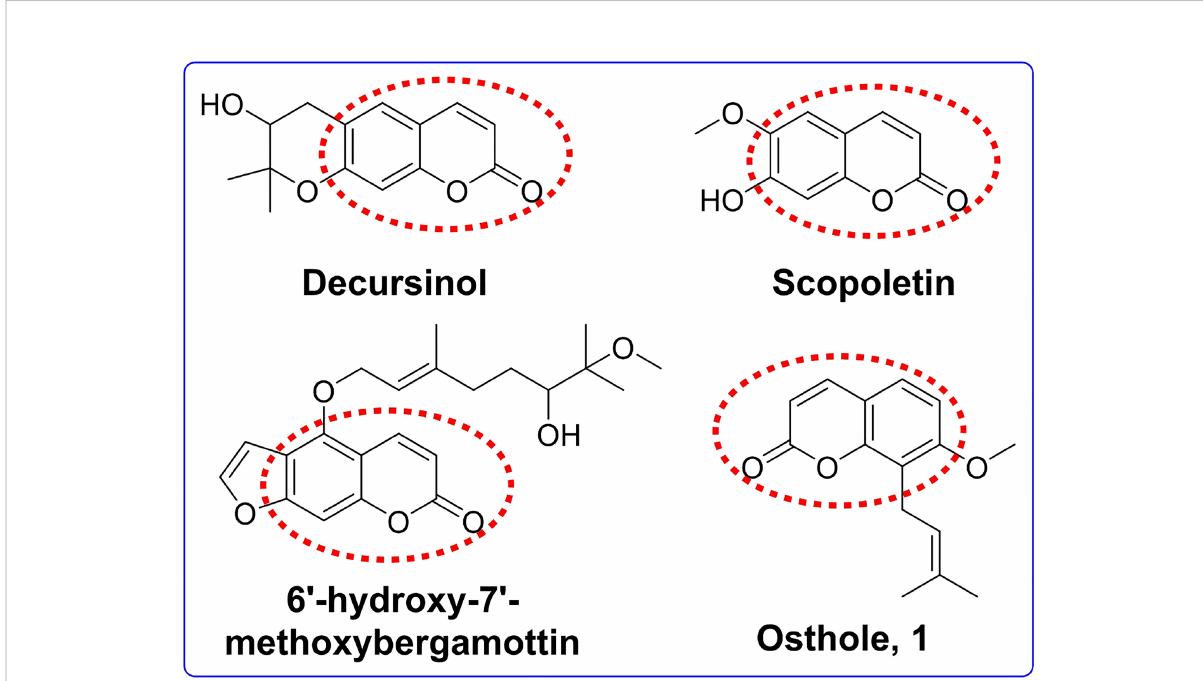
FIGURE 1 The chemical structures of osthole and several potent acetylcholinesterase inhibitors with coumarin